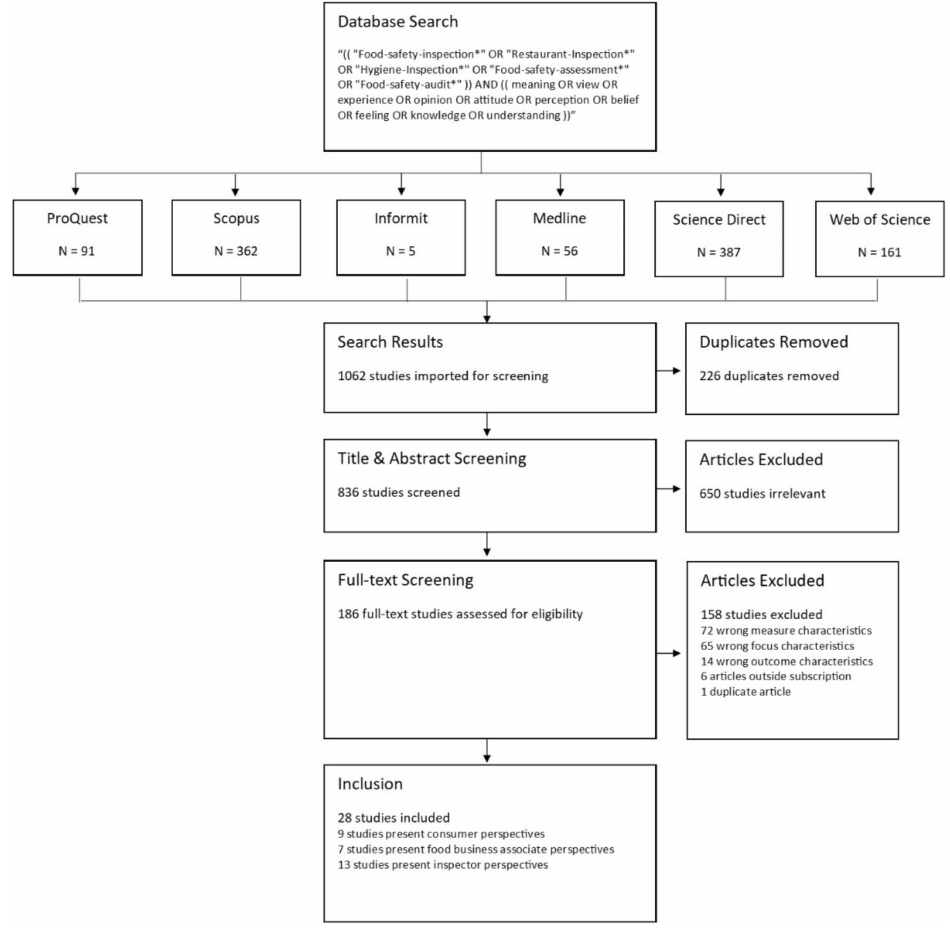
Figure 1. Review flow